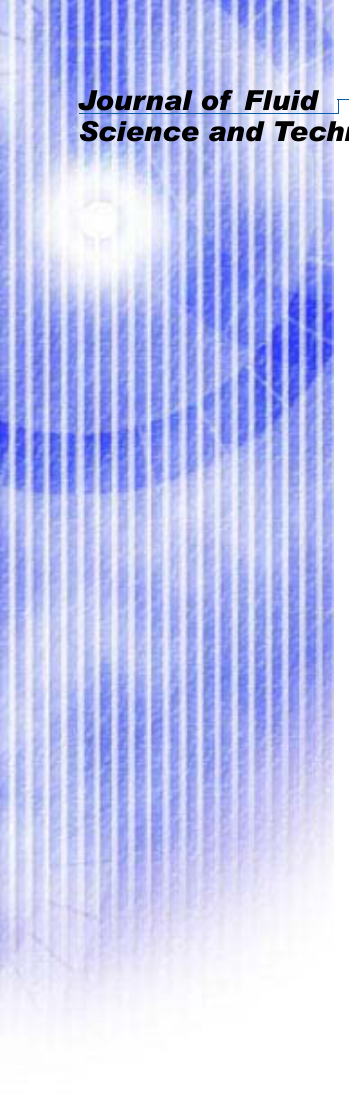
Fig.5 FFT analysis for normal expansion ( Re =1.0 × 10 4 and α